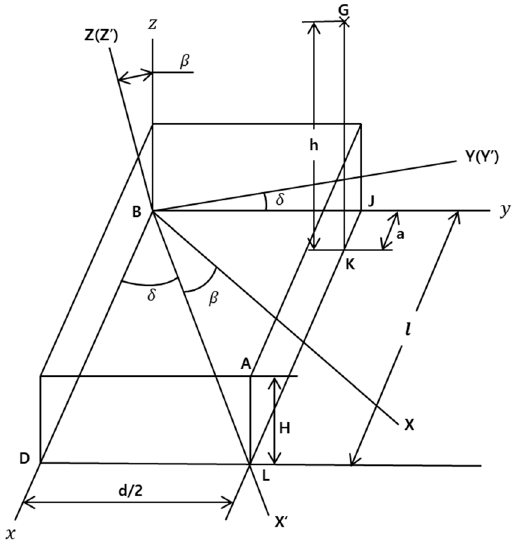
Figure 4. Schematic diagram of the new coordinates for determining different angle changes between new axes.